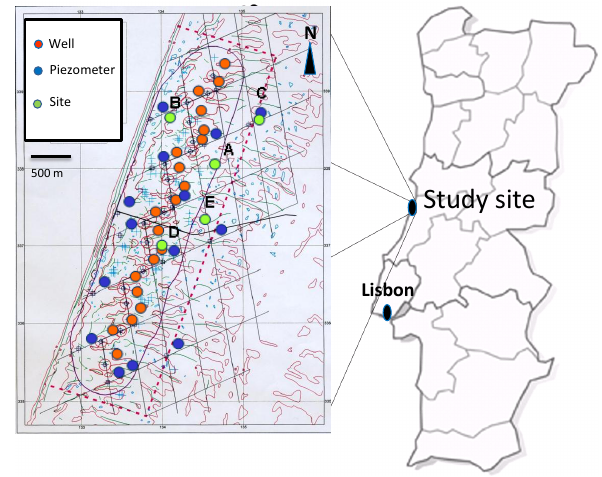
Fig. 1. Map of Osso da Baleia, Portugal indicating locations of the water extraction line, wells, piezometers and field site